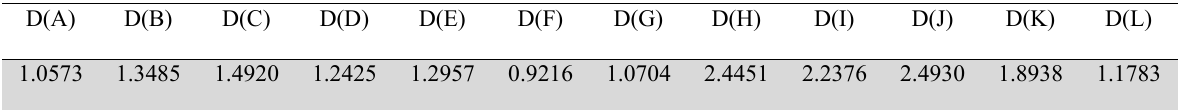
The results of the